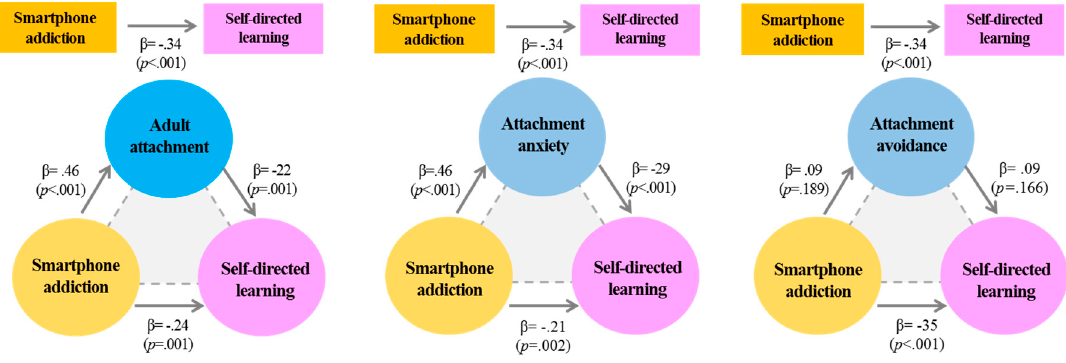
Figure 1. Scheme showing the participants’ adult attachment’s mediating effect on the relationship between smartphone addiction and self-directed learning. β , standardized regression coefficient.